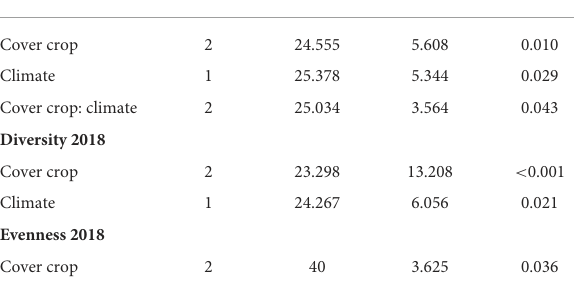
TABLE 1 Type III Analysis of Variance for mixed effect linear models of bacterial richness, Shannon’s Diversity, and Shannon’s Evenness for the 2018 samples.